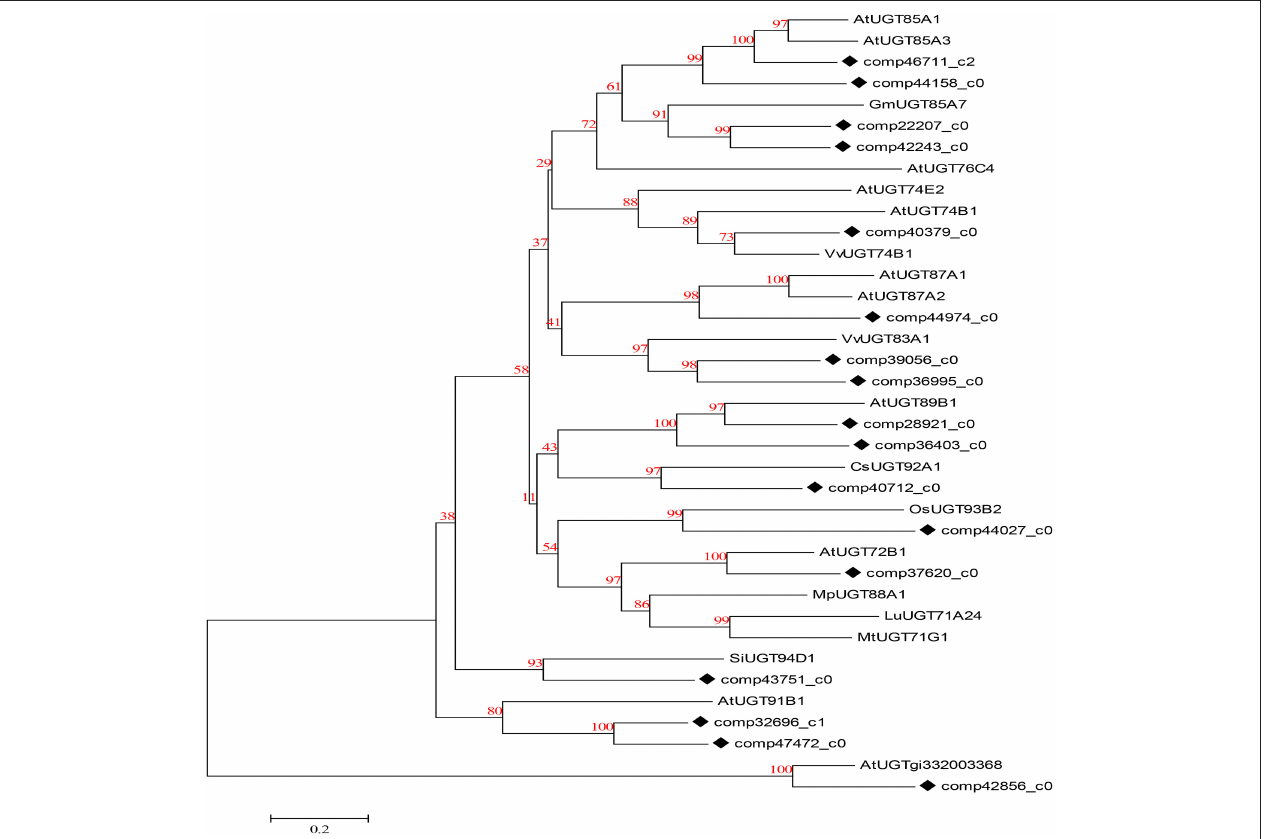
FIGURE 8 | Phylogenetic tree of D. asperoides UGTs. Phylogenetic tree constructed based on the deduced amino acid sequences for the D. asperoides UGTs (solid diamonds) and other plant UGTs. Protein sequences were retrieved from NCBI GeneBank using the following accession numbers (source organisms, if any, are given in parentheses):AtUGT89B1, AEE35520 ( Arabidopsis thaliana ); CsUGT92A1, XP_004142228 ( Cucumis sativus ); OsUGT93B2, CAD41646 ( Oryza sativa ); AtUGT72B1, NP_001190649.1 ( A. thaliana ); MpUGT88A1, ABY73540.1 ( Malus pumila ); LuUGT71A24, AFJ52909 ( Linum usitatissimum ); MtUGT71G1, AAW56092 ( Medicago truncatula ); AtUGT85A1, AEE30237.1 ( A. thaliana ); AtUGT85A3, AEE30236.1 ( A. thaliana ); GmUGT85A7, XP_006577543.1 ( Glycine max ); AtUGT76C4, Q9FI98.1 ( A. thaliana ); AtUGT74E2, AEE27876.1 ( A. thaliana ); AtUGT74B1, AEE30478.1 ( A. thaliana ); VvUGT74B1, XP_002267665.1 ( Vitis vinifera ); AtUGT87A1, AAC16957.1 ( A. thaliana ); AtUGT87A2, O64733.1 ( A. thaliana ); VvUGT83A1, XP_002284331.1 ( V. vinifera ); SiUGT94D1, BAF99027.1 ( Sesamum indicum ); AtUGT91B1, AED98070.1 ( A. thaliana ); and AtUGTgi332003368, AED90751.1 ( A. thaliana